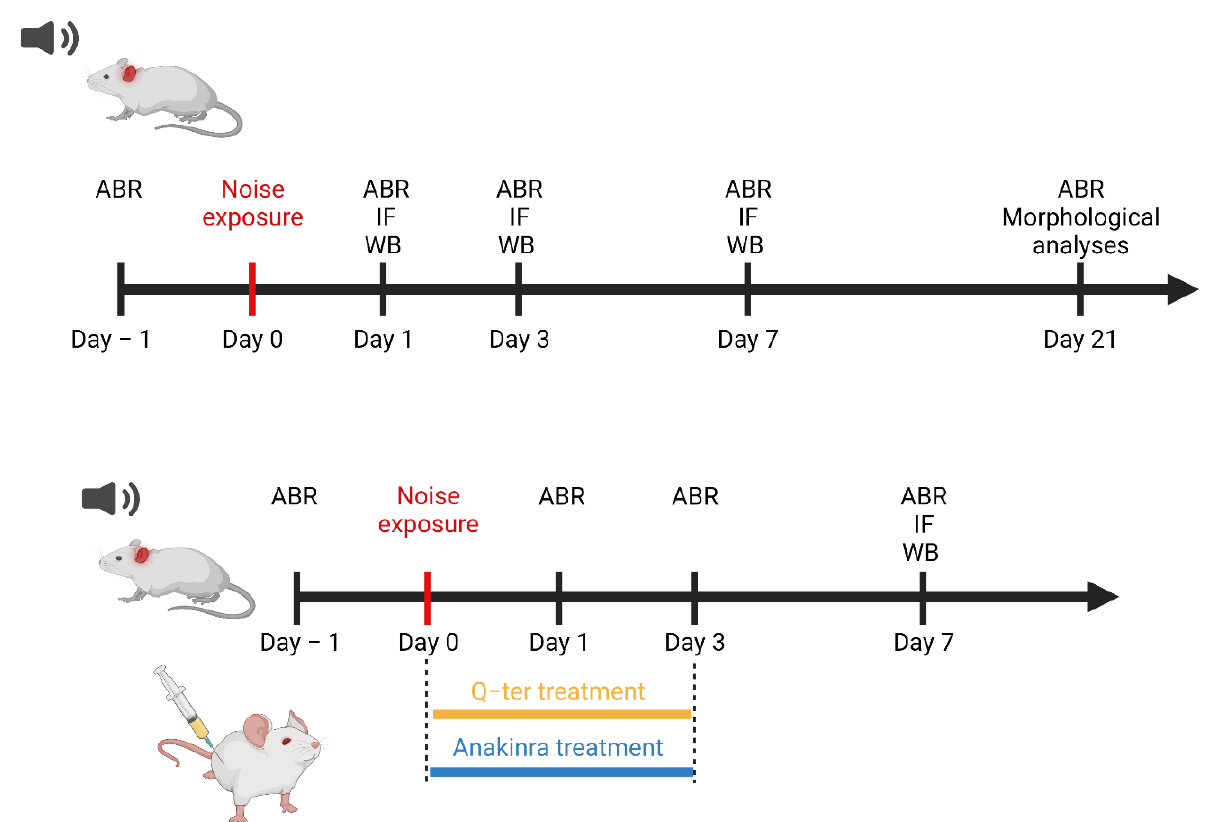
Figure 1. Experimental design and protocol. Male adult Wistar rats 2 months of age at the beginning of the study were used. Baseline hearing thresholds were evaluated the day before the exposure to noise (pure tone, 10 kHz, 120 dB SPL, 60 min). A cohort of animals was treated with Q-ter (100 mg/kg) or Anakinra (40 mg/kg) 1 h before and for the following 3 days after noise exposure. Functional, morphological and molecular (WB/IF) evaluations were performed at different time points after noise exposure (from day 1 to day 21). ABR: auditory brainstem response; IF: immunofluorescence; WB: Western immunoblot.